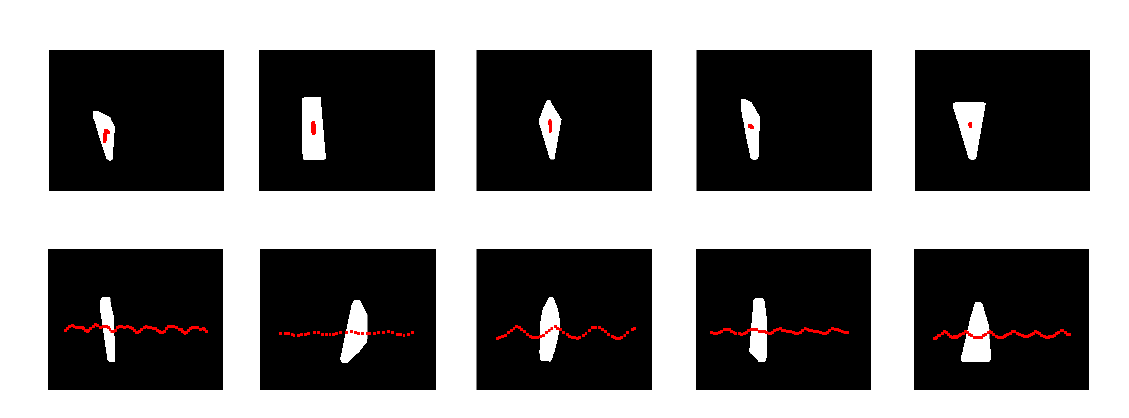
Figure 2. Exemplary trajectories for ten different actions of one actor: actions performed in place are in the top row (bending, jumping-jack, jumping in place, one-hand waving and two-hand waving) and actions with changing location of a silhouette are depicted in the bottom row (jumping forward, running, galloping sideways, skipping and walking). Centroid trajectory is displayed over sample frame from a corresponding video